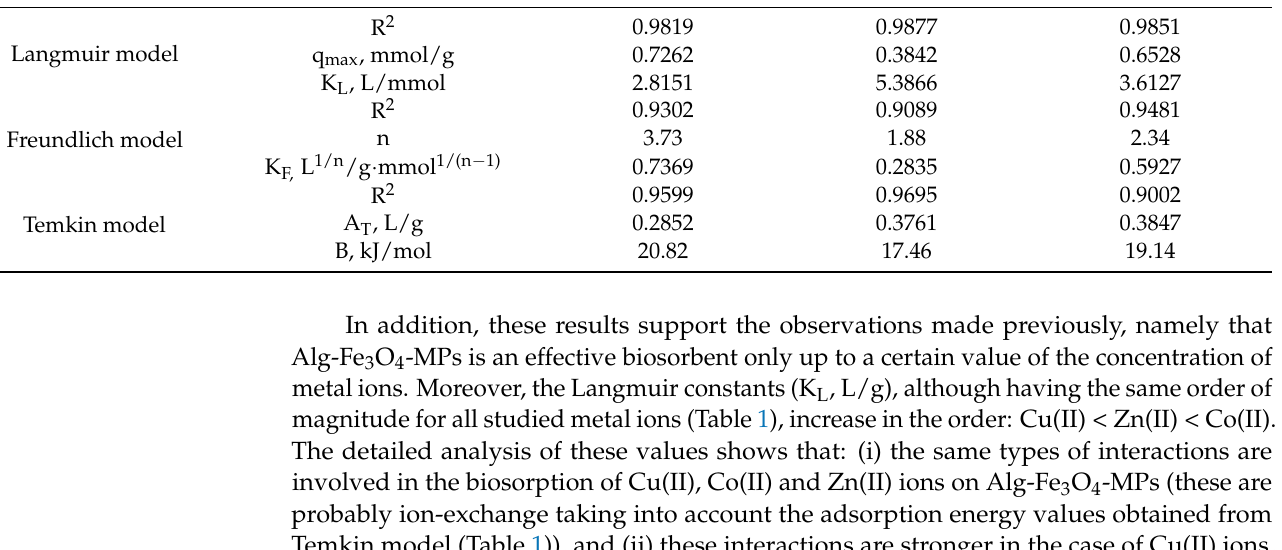
Table 1. Isotherm parameters for Cu(II), Co(II) and Ni(II) ions biosorption on Alg-Fe 3 O 4 -MPs. Isotherm Parameter R Langmuir model